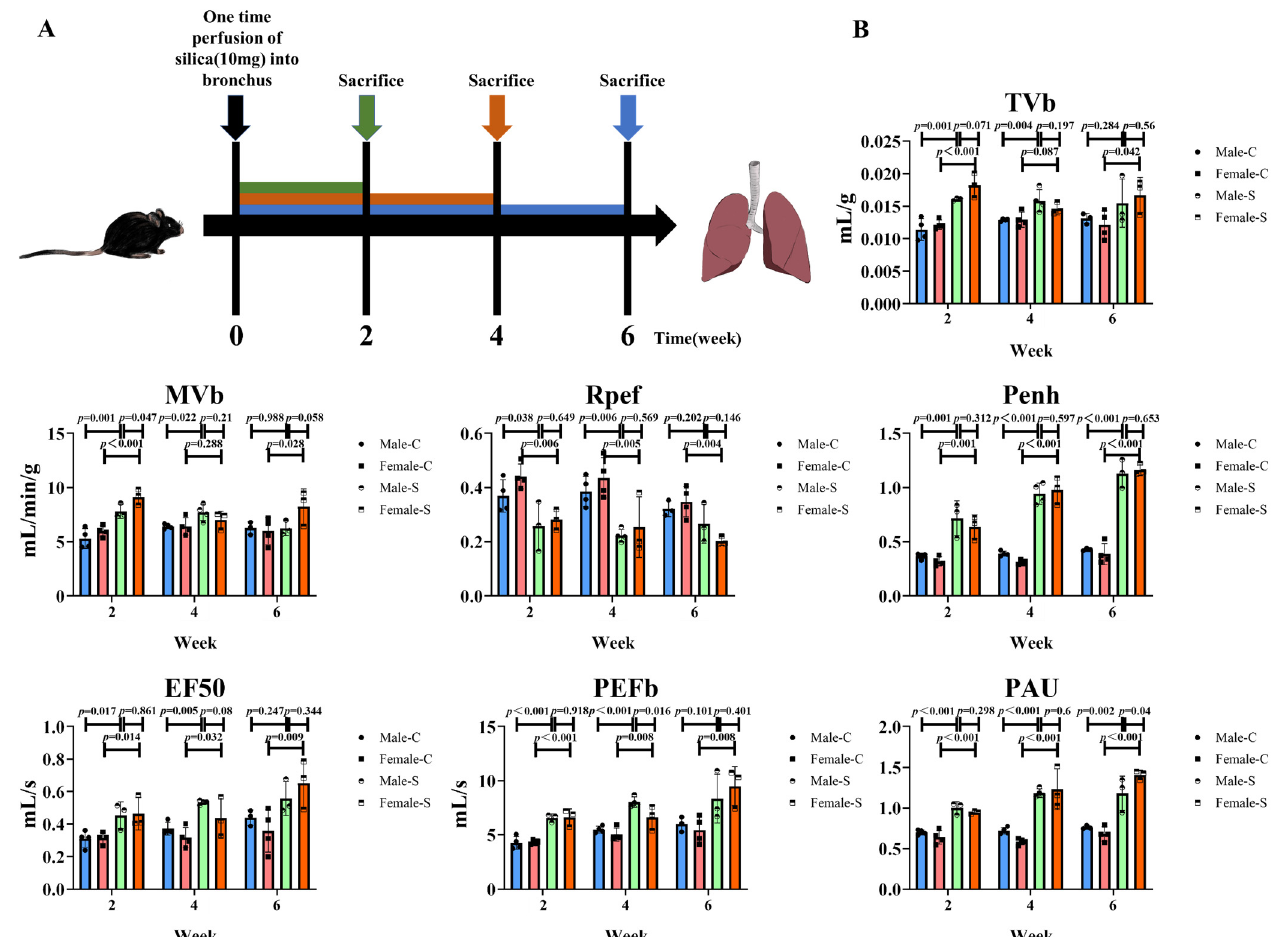
Figure 1. Indexes of the pulmonary function of male and female mice exposed to silica in two, four, and six weeks, and the control groups. ( A ) Schematic diagram of a silicotic model establishment and execution. ( B ) Detection indexes of a lung function, n = 5 per group.